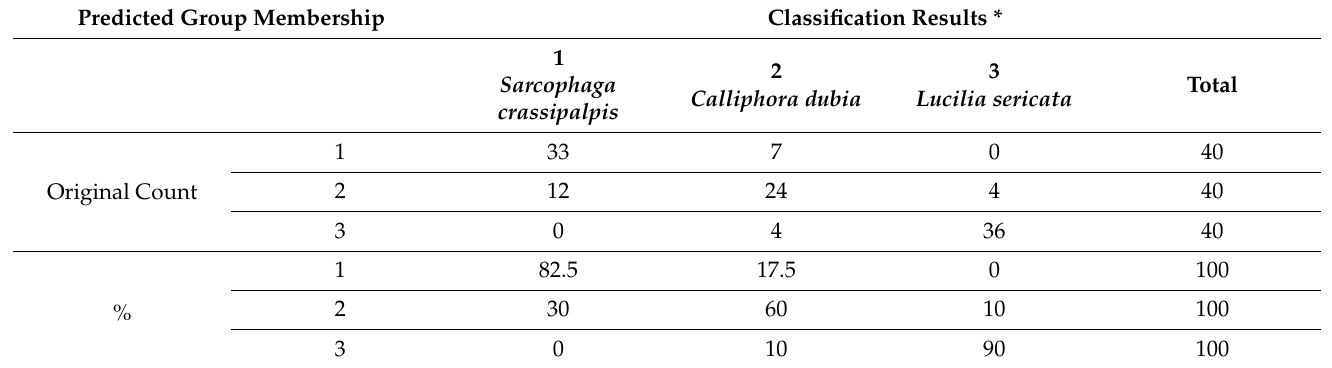
Figure 4. Individual specimen’s mean wingbeat frequencies for each of the four recorded species. Discriminant analysis classifying the three carrion flies ( S. crassipalpis, C. dubia, and L. sericata ) resulted in 77.5% classified correctly overall, with 82.5% of S. crassipalpis correctly classified, 60% of C. dubia correctly classified, and 90% of L. sericata correctly classified, when both mean wingbeat frequency and sex were included as independents. Discriminant analysis using only wingbeat frequency resulted in a less accurate prediction model with 70.8% correctly classified overall, 67.5% of S. crassipalpis correctly classified, 62.5% of C. dubia correctly classified, and 82.5% of L. sericata correctly classified (Table 3). Table 3. Discriminant analysis of the three carrion flies using mean wingbeat frequency and sex as independents.